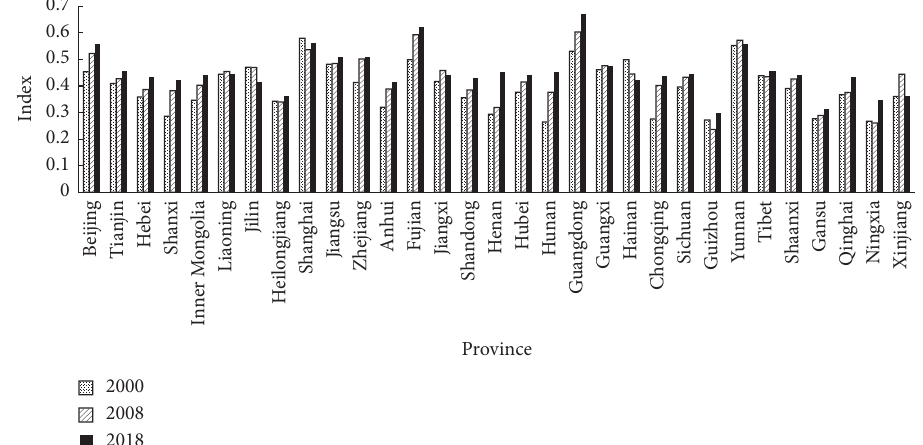
Figure 3: Spatial differentiation of China’s ecological civilization construction (2000, 2008, and